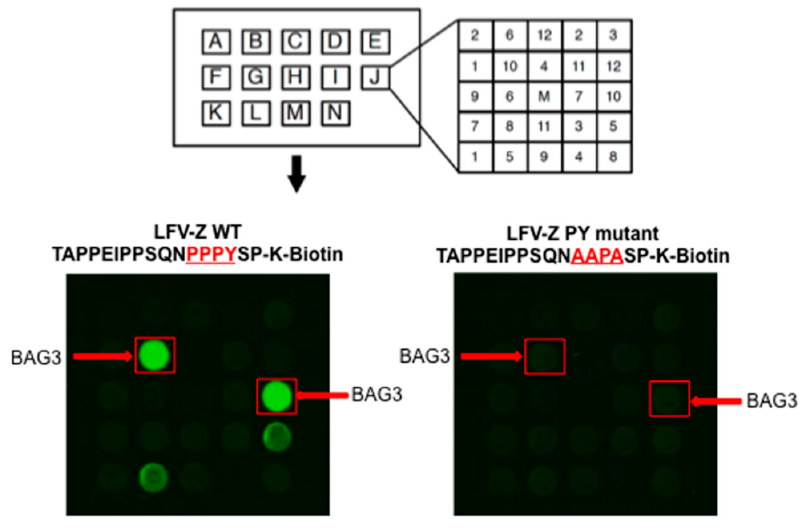
Figure 1. Identification of an interaction between host BAG3 and LFV-Z. Schematic diagram of the GST-WW and GST-SH3 array chip is shown in the top panel. Each lettered square contains one mock (M) and 12 numbered GST-WW or -SH3 domain fusion proteins in duplicate. Fluorescence labeled biotinylated LFV-Z-WT (TAPPEIPPSQNPPPYSP-K-Biotin) and LFV-Z PY mutant (TAPPEIPPSQNAAPASP-K-Biotin) peptides were used to screen the array. A strong interaction between the LFV-Z-WT peptide and the WW-domain of BAG3 was indicated by bright green fluorescent spots shown in the red squares and indicated by the red arrows. No interaction was detected between LFV-Z-PY mutant peptide and BAG3 as shown in the bottom right panel (red squares and arrows).